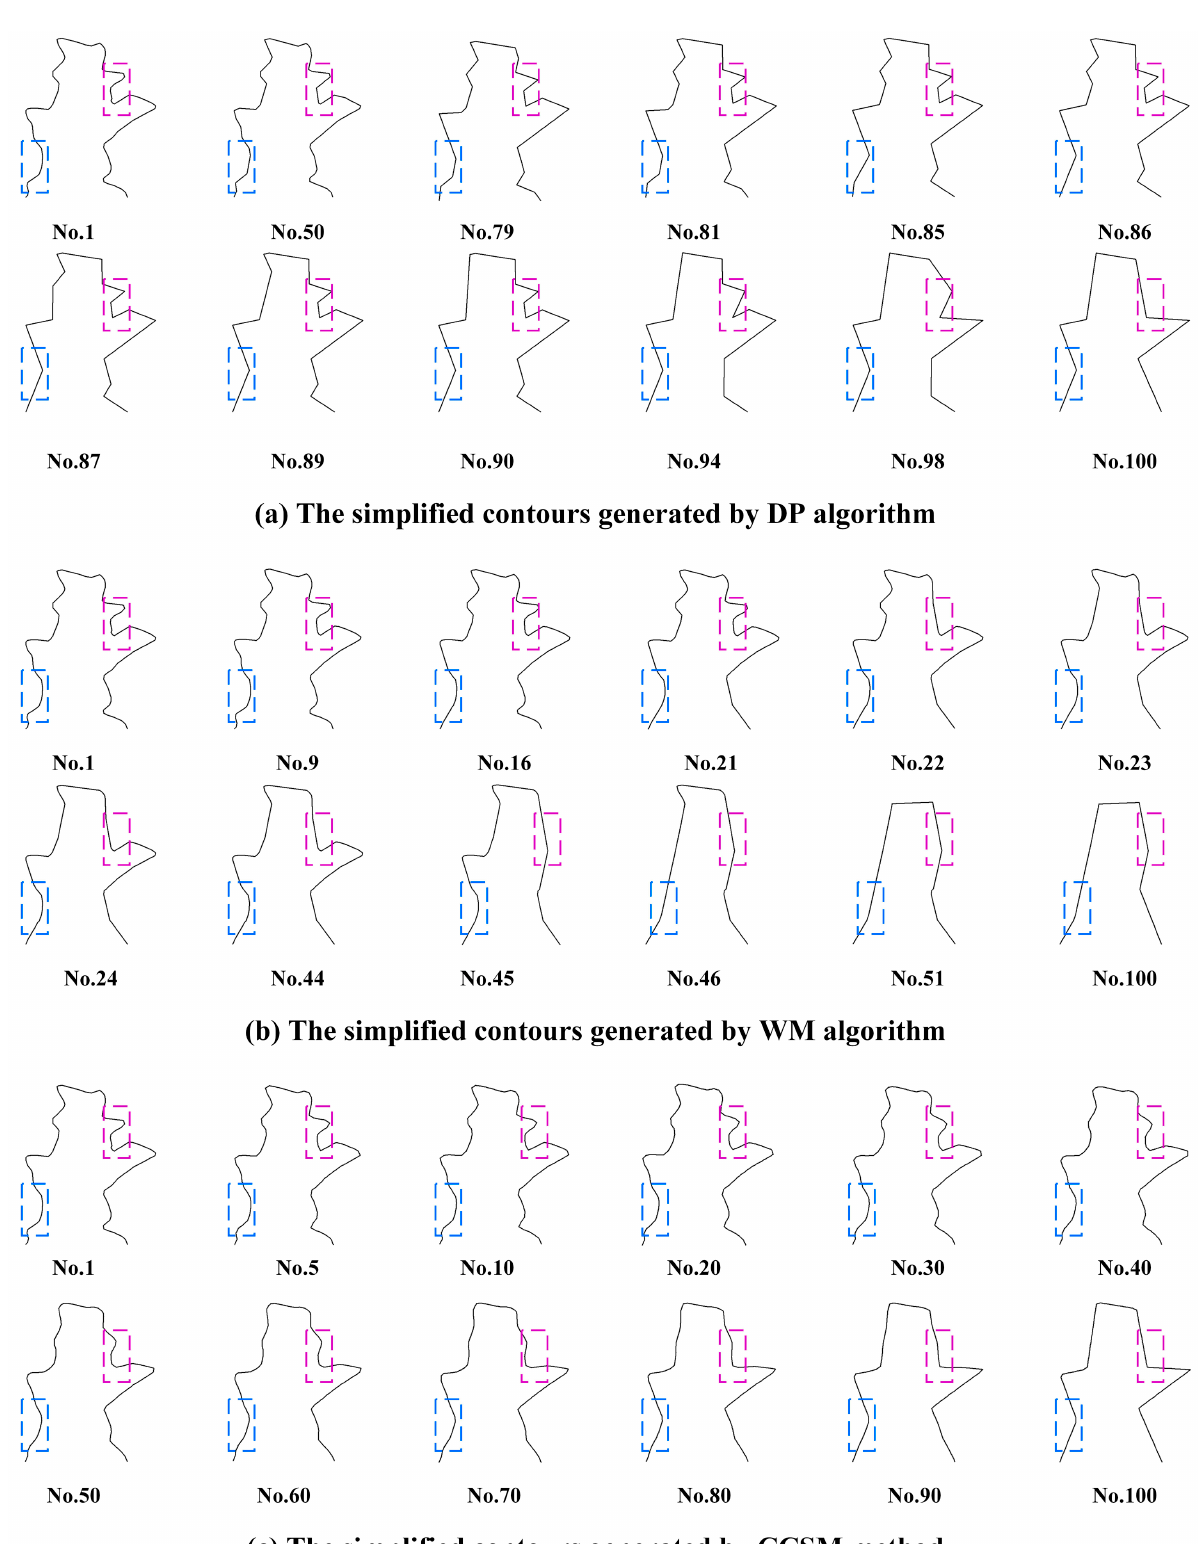
Figure 9. Simplified contours generated by the DP algorithm, the WM algorithm, and the CCSM method. ( a ) The simplified contours generated by DP algorithm. ( b ) The simplified contours generated by WM algorithm. ( c ) The simplified contours generated by CCSM method.